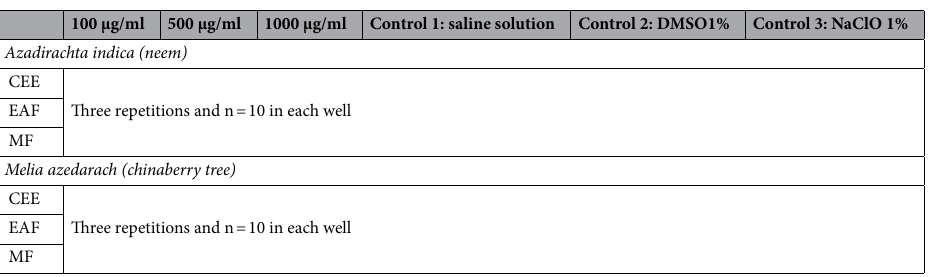
Table 5. Sampling distribution of Artemia salina Leach nauplii in the LC 50 test with the crude extracts of Azadirachta indica and Melia azedarach and their respective fractions of ethyl acetate and methanol. DMSO, dimethyl sulfoxide; NaClO, sodium hypochlorite; CEE, crude ethanolic extract; EAF, ethyl acetate fraction; MF, methanol